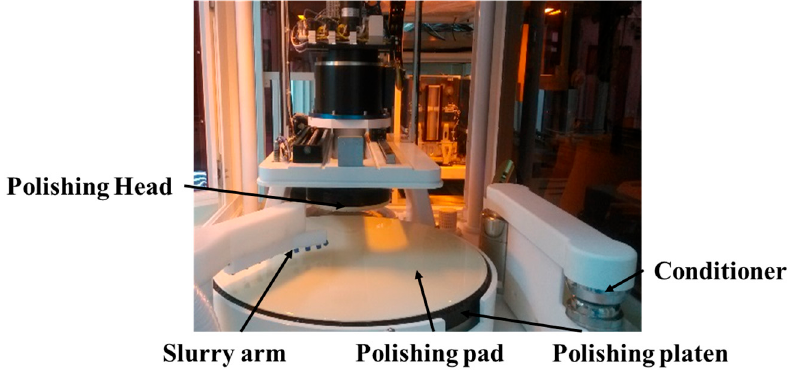
Figure 1. Chemical mechanical planarization (CMP) system used for experiment.